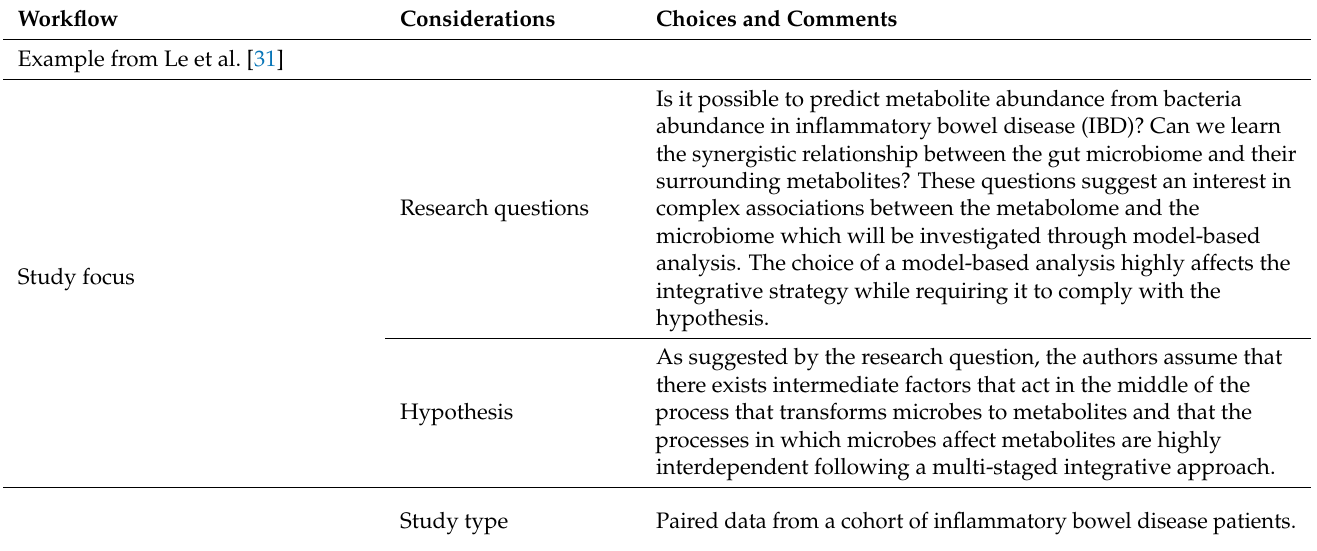
Table 2. Case study examples underlining considerations that researchers should make when carrying out multi-omics experiments and analyses. Integrative analysis that is driven by a hypothesis should result in a data interpretation that links back to that hypothesis (see Section 5). Hence the underlying hypothesis should be considered along with the research question but also at the data interpretation